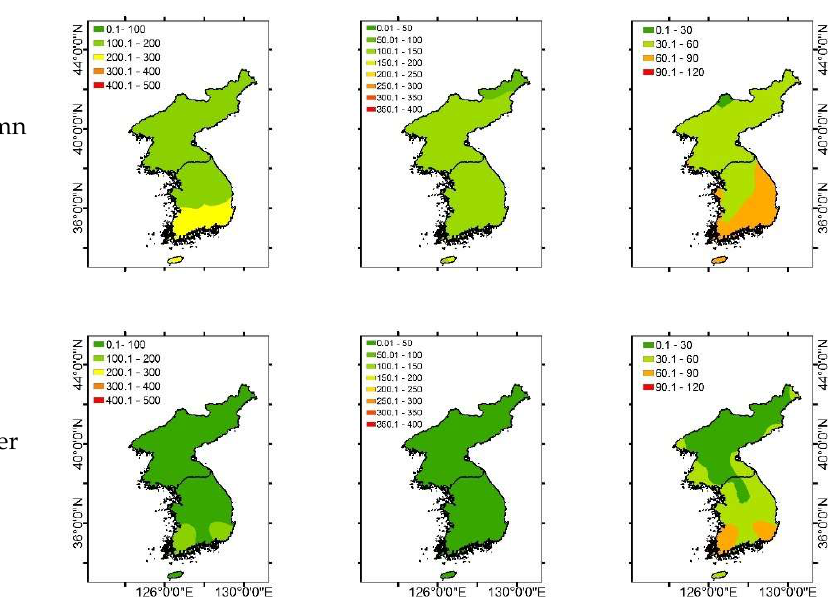
Figure 5. Spatial distribution of mean annual ET (cid:2925) , EN (cid:2925) , and AE (cid:2925) on annual and seasonal scales.